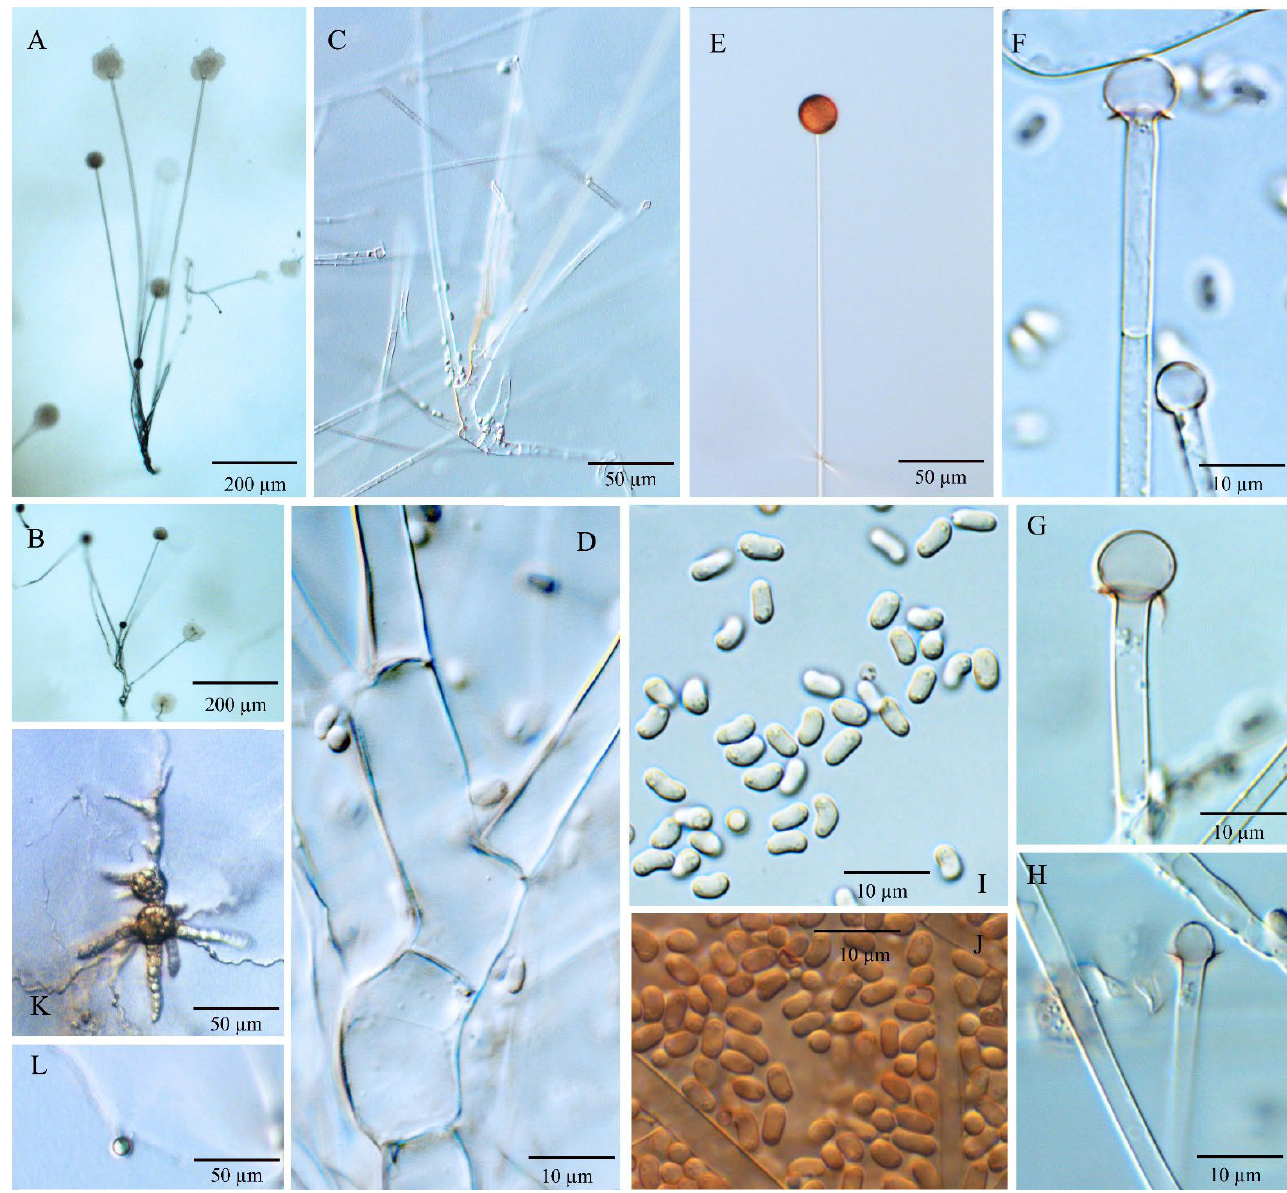
Figure 2. Umbelopsis curvata . ( A – C ) Branched sporangiophores. ( D ) Branch point of sporangiophore. ( E ) Sporangium at tip of sporangiophore. ( F – H ) Various shapes of collars and columellae at sporangiophore tips after the sporangia have been dissolved. ( I , J ) Sporangiospores. ( K ) Macro-chlamydospores. ( L ) Micro-chlamydospore.